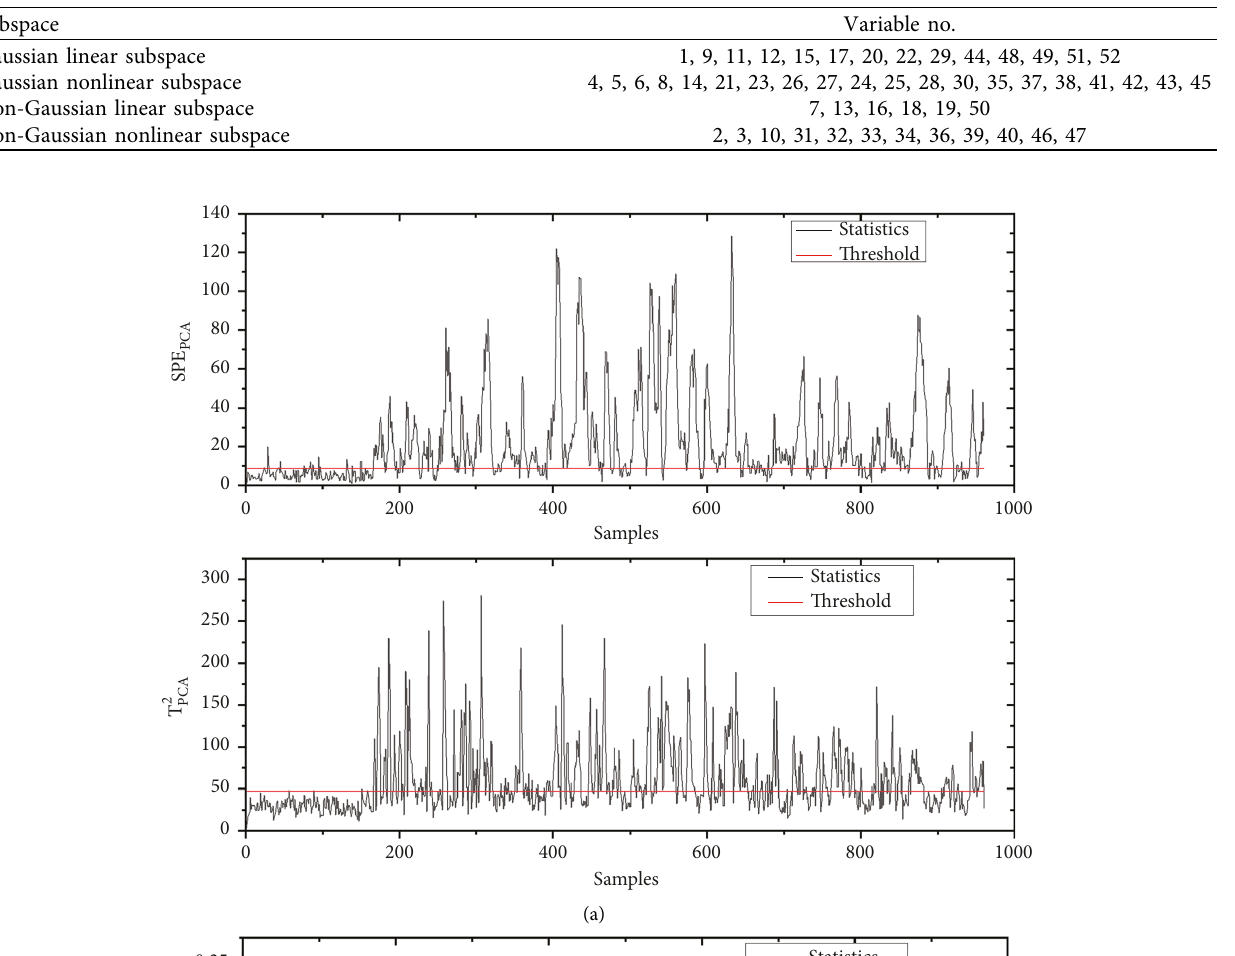
Table 3: Variable division in each subspace.